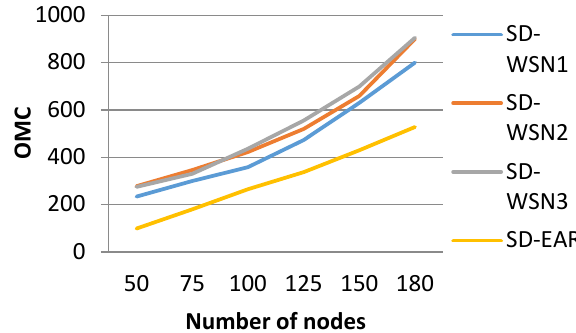
Figure 16. OMC vs. number of nodes.